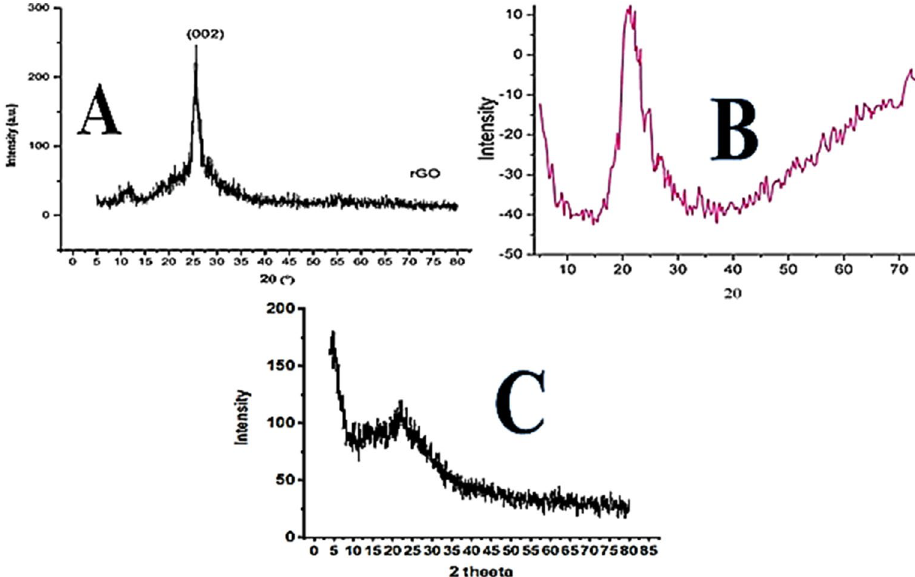
Figure 3. XRD pattern of Graphene oxide ( A ), Silica particles ( B ), and silica modified graphene oxide composite ( C